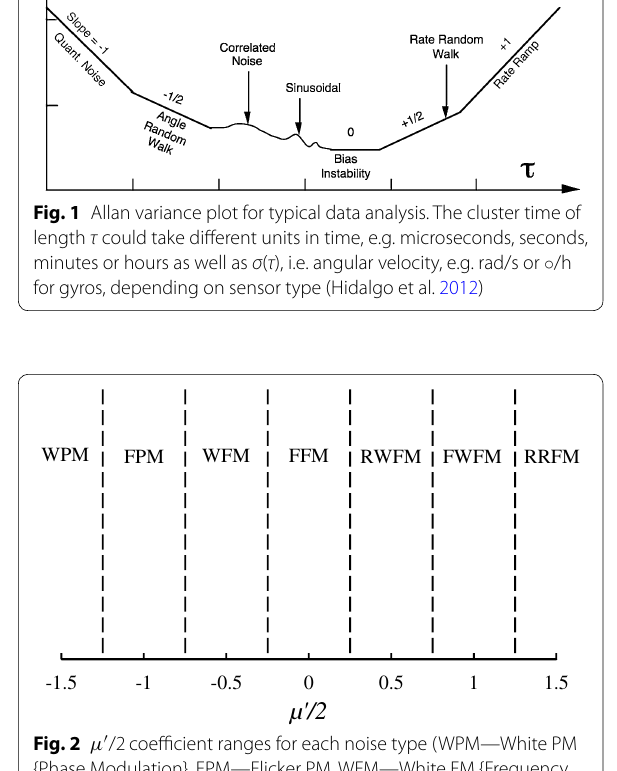
Fig. 2 µ ′ /2 coefficient ranges for each noise type (WPM—White PM {Phase Modulation}, FPM—Flicker PM, WFM—White FM {Frequency Modulation}, FFM—Flicker FM, RWFM—Random Walk FM, FWFM— Flicker Walk FM, RRFM—Random Run FM)